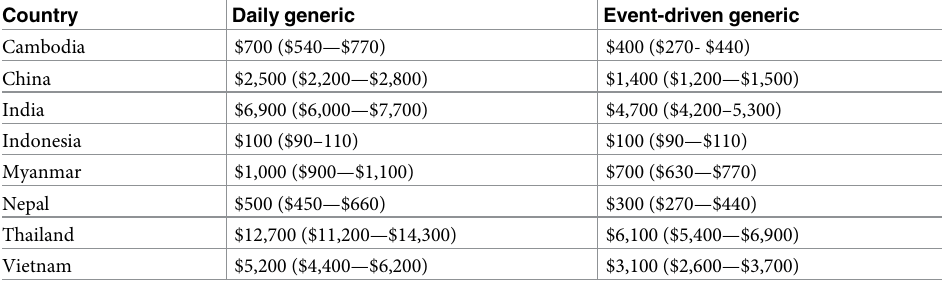
Table 5. Estimated cost per HIV-related DALY averted by 2051 �